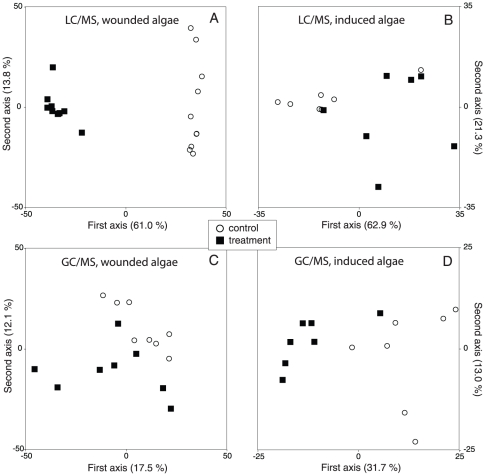
LC/MS and GC/MS metabolic profiling.Principal coordinate analysis of RT- m/z pairs derived from LC/MS and GC/MS analyses of Gracilaria vermiculophylla extracts. A & C: Extracts from mechanically wounded algae and controls, analysed by LC/MS and GC/MS, respectively. B & D: Extracts from algae exposed to extracts from previously mechanically wounded and control tissue, analysed by LC/MS and GC/MS, respectively. Numbers in brackets are the percentages of original variance explained by the derived axes.